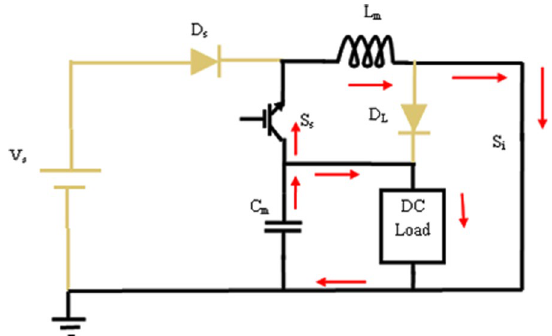
Fig. 3 Operation of inverter in (D c .T p ) interval